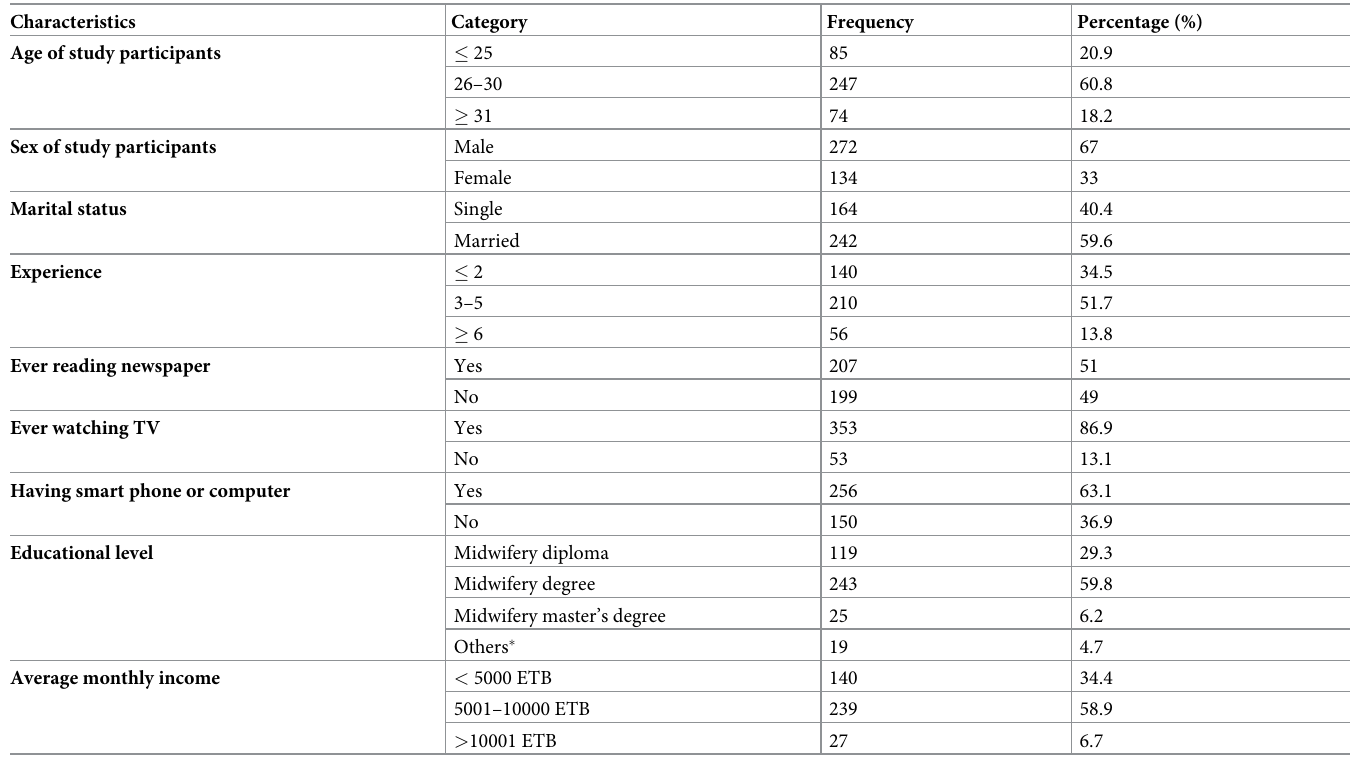
Table 1. Socio-demographic characteristics of study participants in hospitals of Gondar province, northwest Ethiopia, 2020/2021 (n = 406).